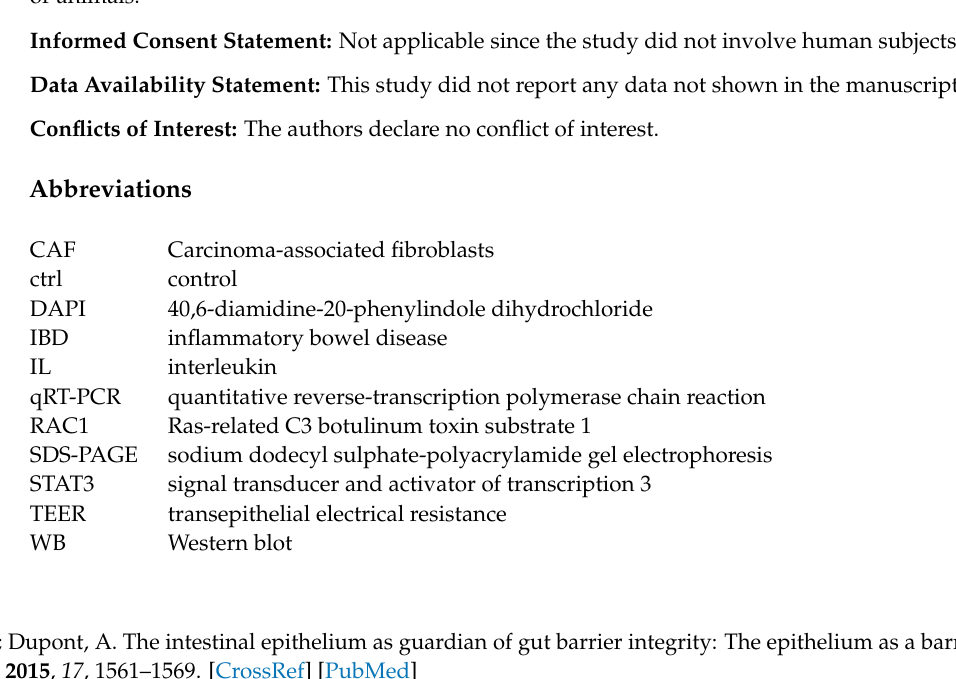
cells, Table S1: Characteristics of the colorectal cell lines used, Table S2: Primers used for RT-PCR amplification